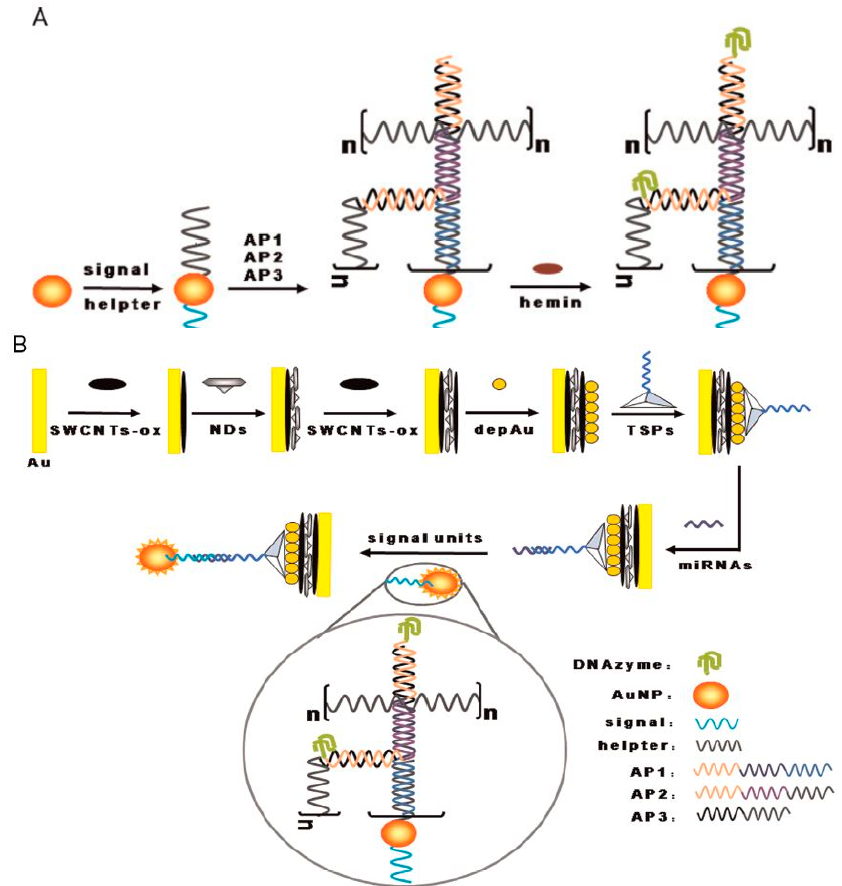
Figure 11. ( A ) DNA-functionalized AuNP based hybridization chain reaction, ( B ) Schematic illustration of miRNA biosensor using layered nanostructure of oxidized single-walled carbon nanotubes and nanodiamonds by hybridization chain reaction (reproduced with permission from the publisher) [129].